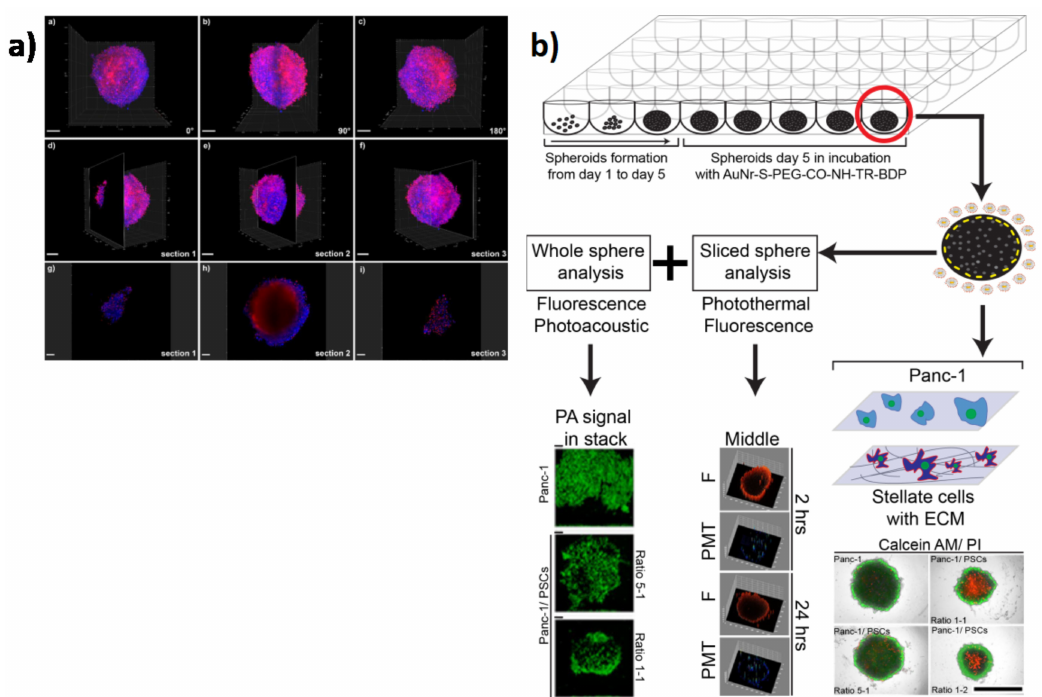
Figure 5. Nanoparticle applications in 3D in vitro models of PC. ( a ) 3D tomography with light sheet fluorescence microscopy of large hetero-type multicellular tumor spheroids after incubation with doxorubicin (Dox). Overlays of blue (nuclei, Hoechst 33342 staining) and red (Dox) channels. ( a ) 0 ◦ rotation, ( b ) 90 ◦ rotation, and ( c ) 180 ◦ rotation. Localization of ( d ) section 1 (113 µ m depth), ( e ) section 2 (403 µ m depth), and ( f ) section 3 (861 µ m depth) in relation to the entire spheroid. Scale bars: 200 µ m. Images taken at ( g ) section 1, ( h ) section 2, and ( i ) section 3. Scale bars: 100 µ m (adapted from [115]). ( b ) Schematic of the experimental approach: spheroid formation (day 1 to day 5) in ultra-low-attachment 96-well plate, functionalized gold nanodor (AuNR) incubation, followed by characterization of the whole sphere and a section of it (adapted from